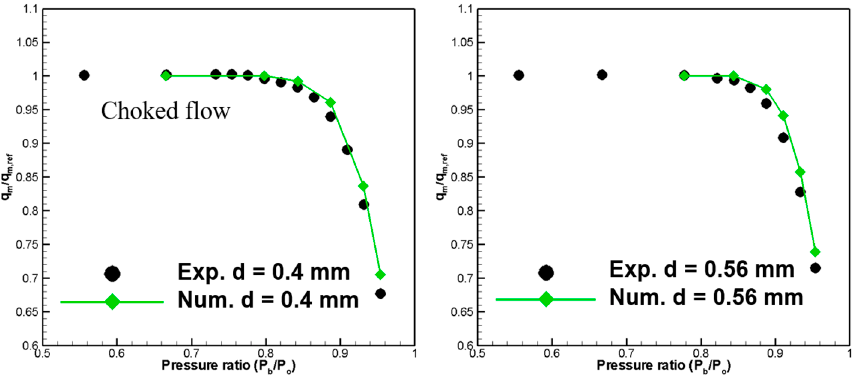
Figure 7. Mass flow rate according to variation of exit pressure; left : d = 0.4 mm; right : d = 0.56 mm.